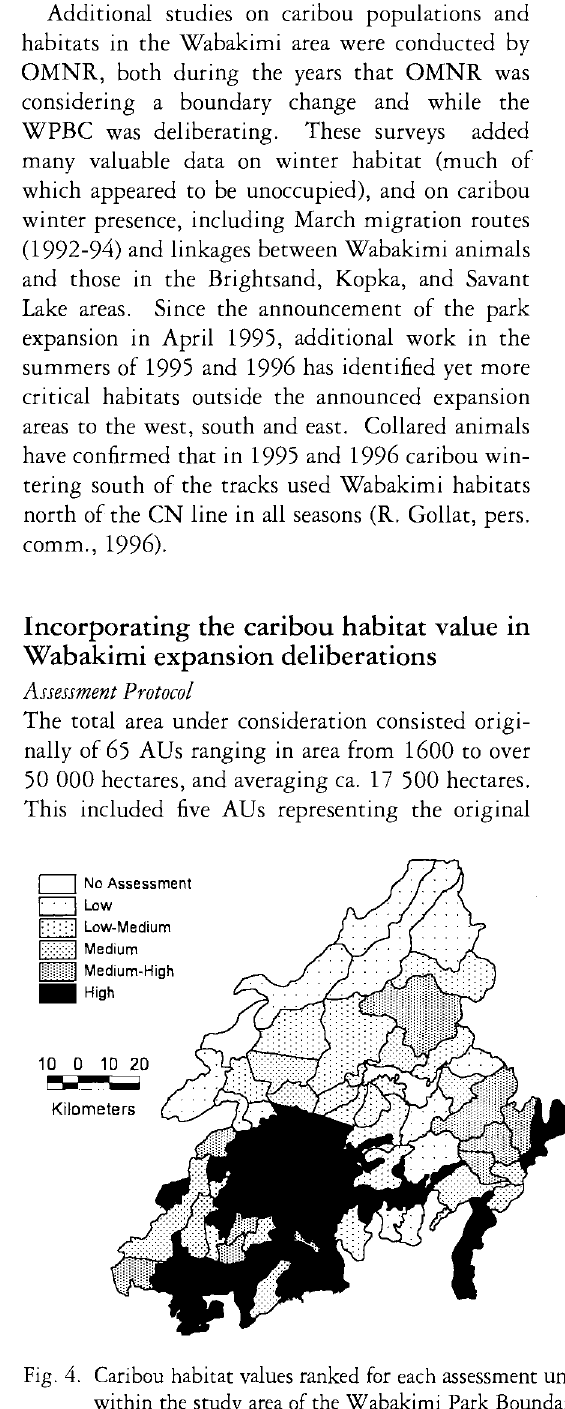
Fig. 4. Caribou habitat values ranked for each assessment unit within the study area of the Wabakimi Park Boundary